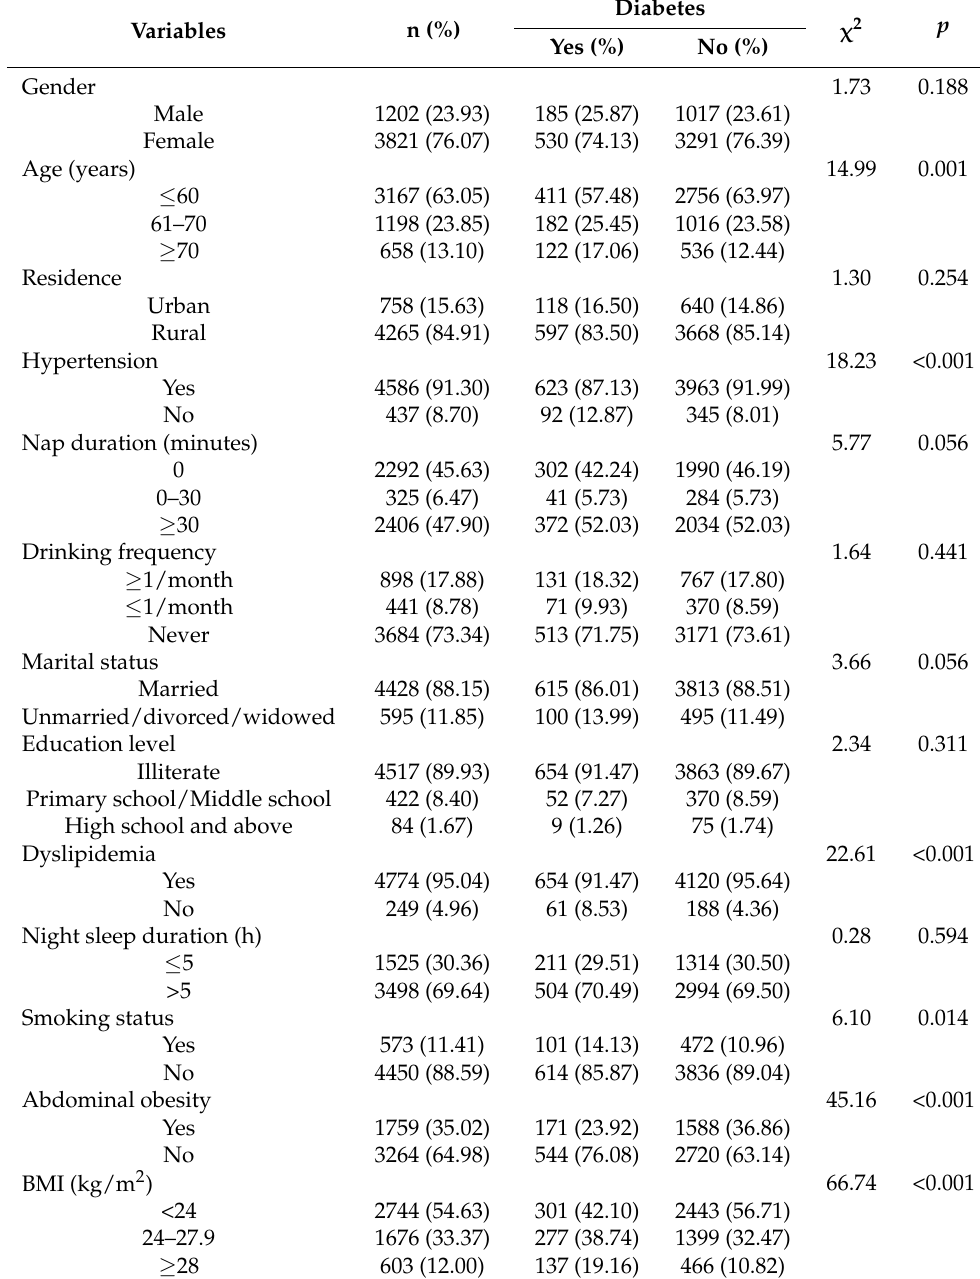
Table 1. The prevalence of diabetes in people with different